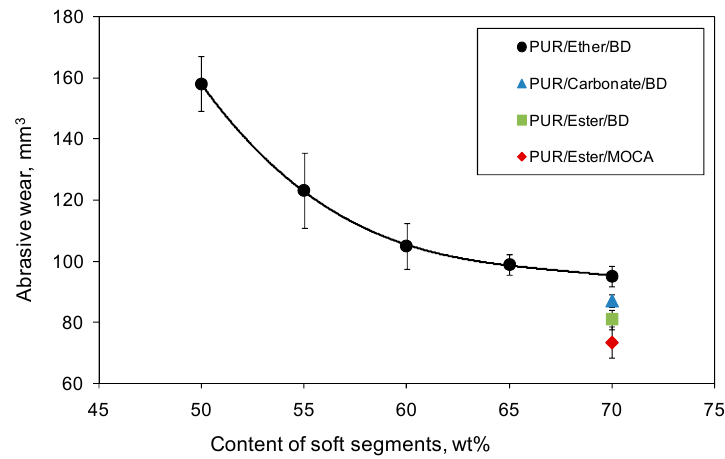
Figure 3. Abrasion wear of polyurethane elastomers (PUR) with various chemical composition and different contents of Soft Segment (SS). The 95% confidence interval is indicated with ISO 2602:1980.